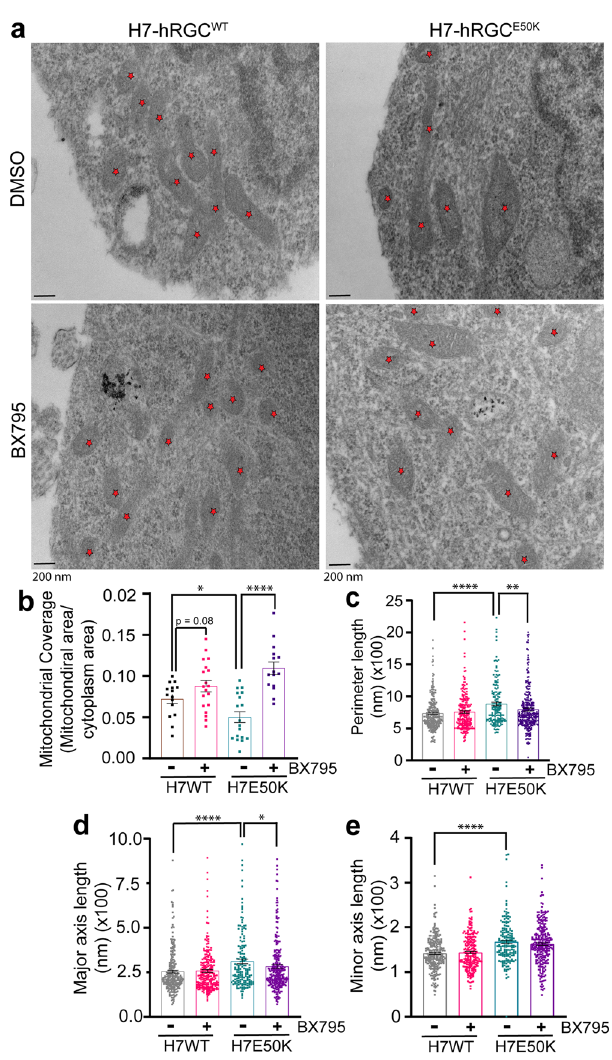
Fig. 5 TBK1 inhibition improves mitochondrial coverage and mitigates swelling in E50K hRGCs. a TEM images of H7-hRGC WT and H7-hRGC E50K after 24 h DMSO or BX795 (1 μ g/ml) treatment, at 49000X magni fi cation. Asterisks represent mitochondria. Scale bar = 200 nm. Quanti fi cation of b mitochondrial coverage (mitochondrial area/cytoplasm area) for each image, c perimeter length, d major axis length, and e minor axis length for each mitochondrion. b Unpaired student ’ s t -test or c – e Mann – Whitney U test between independent datasets, ٭ p -value < 0.05, ٭٭ p -value < 0.01, ٭٭٭٭ p -value < 0.0001, n = 15 – 24. Error bars are